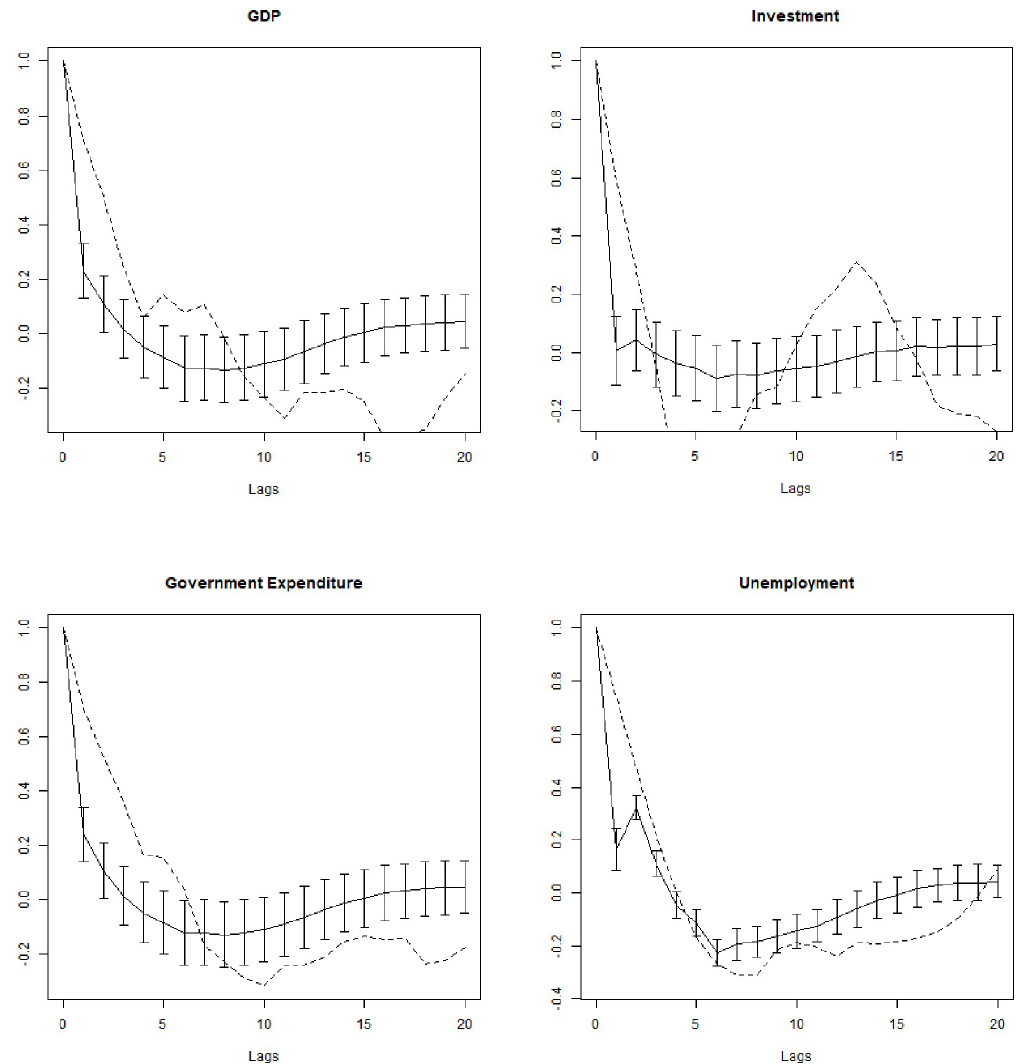
Fig 3. Average artificial (continuous) and real (dashed) auto-correlations of the de-trended series up to the 20 th lag. Bars are standard deviations of Monte Carlo average auto-correlations.